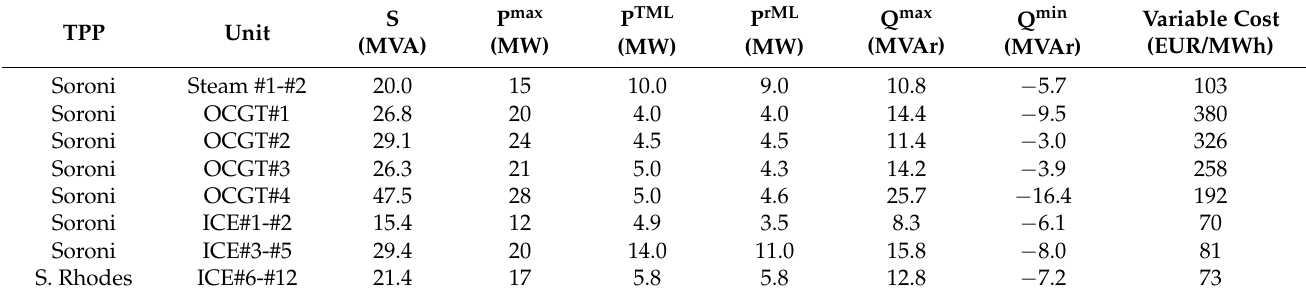
Table A1. Technical and economic characteristics of thermal